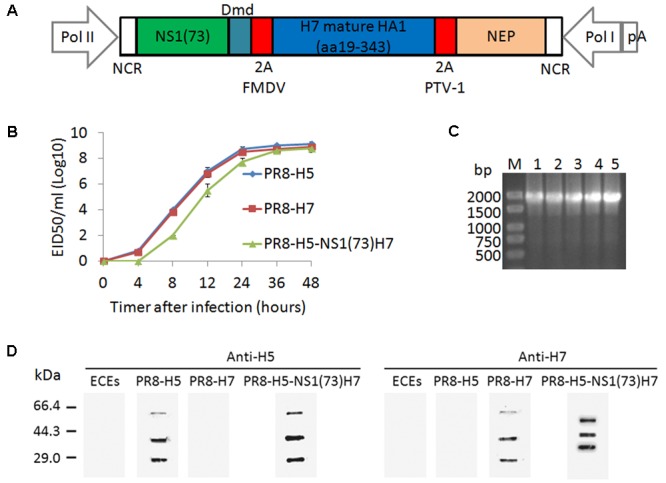
In vitro characterization of the PR8-H5-NS1(73)H7 virus. (A) Schematic representation of the promoters and coding sequences of the pHW-NS1(73)-H7 HA1-NEP plasmid used to generate the recombinant influenza virus. (B) The growth kinetics of PR8-H5-NS1(73)H7 and PR8-H5 were examined in ECEs. The allantoic fluids were collected and titrated in ECEs of each virus inoculated at 4, 8, 12, 24, 36, and 48 h post-infection with 104 EID50. The data are presented as the mean and standard error of each data point. (C) Genetic stability of PR8-H5-NS1(73)H7 in chicken embryos, as determined with RT-PCR. (1) pHW plasmid encoding the NS1(73)-H7 HA1-NEP genes; (2) Passage 1 of PR8-H5-NS1(73)H7; (3) Passage 3 of PR8-H5-NS1(73)H7; (4); Passage 5 of PR8-H5-NS1(73)H7; (5) Passage 10 of PR8-H5-NS1(73)H7. (D) Uninfected ECEs and ECEs infected with PR8-H5 virus, PR8-H7 virus, or PR8-H5-NS1(73)H7 virus and the allantoic fluids were purified by ultracentrifugation through a 20% sucrose cushion. The proteins were visualized with western blotting and immune-detection with an anti-H5 or anti-H7 antibody.